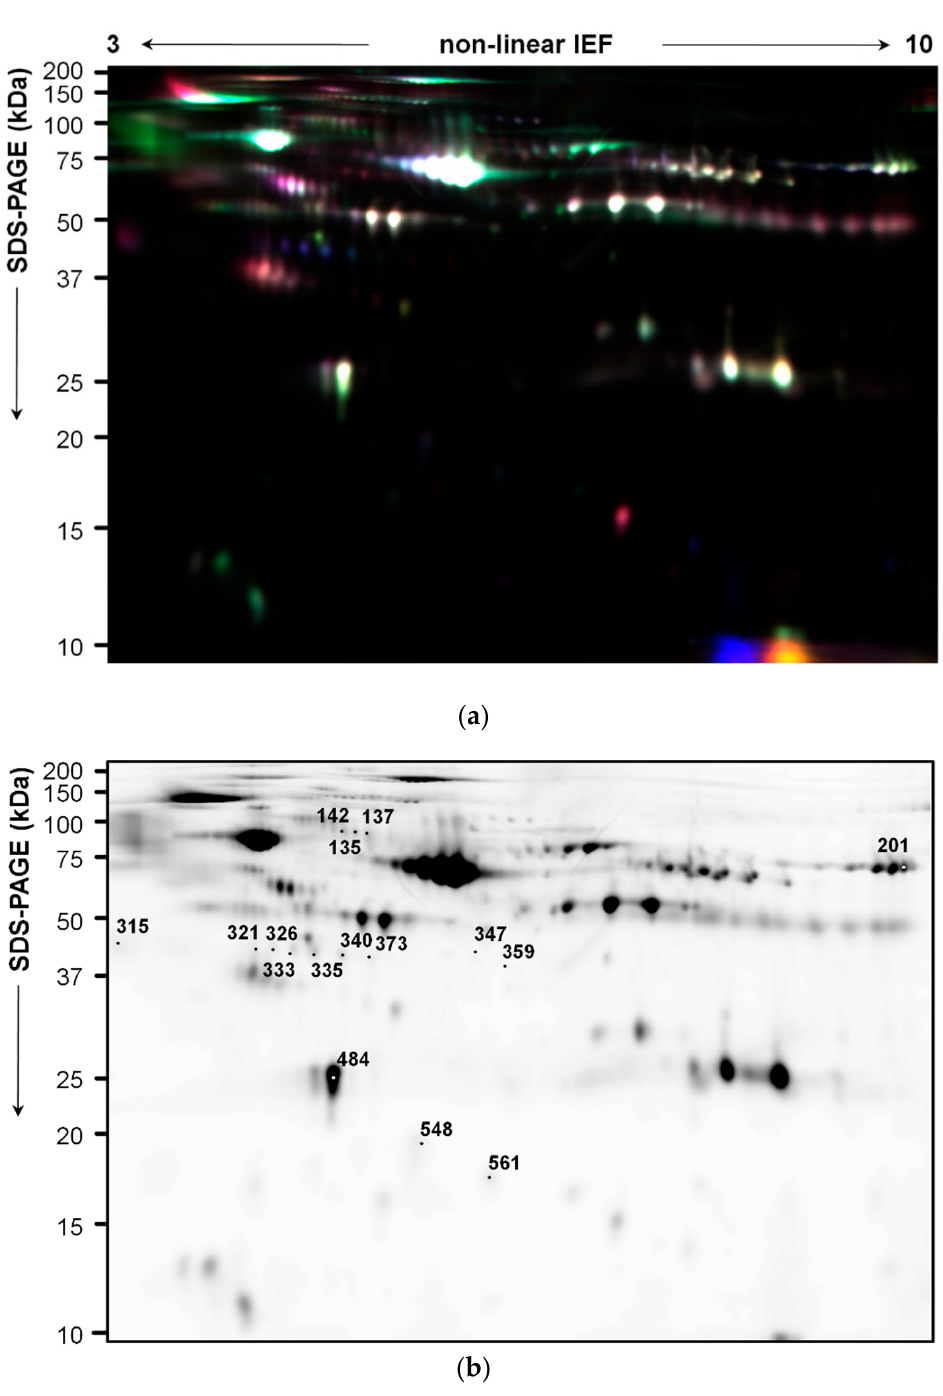
Figure 4. Two-dimensional proteome maps of pediatric HL EVs. Proteins were resolved by IEF on immobilized pH 3–10 non-linear gradients, followed by SDS-PAGE (12.5%). ( a ) A DIGE image of a picking gel loaded with 25 µ g each of EV protein from two non-relapsed HL patients (stained with Cy3 or Cy5 dye) and an equal amount of the Cy2-labeled internal standard. ( b ) Coomassie blue-stained preparative gel loaded with 200 µ g protein. The numbers indicate the differentially abundant spots between non-relapsed and relapsed HL groups (|fold change| ≥ 1.5, Student’s t -test p < 0.05).